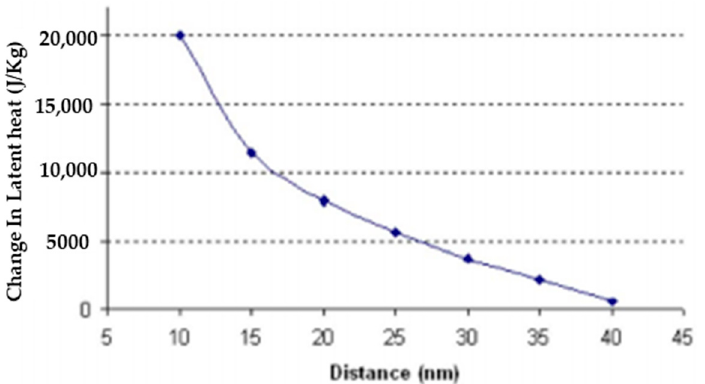
Figure 19. Relationship between latent heat transfer of shell wax/CNT NEPCM with distance between the CNT nanoparticles and PCM molecules. (Reprinted with Permission from ref. [33]. Copyright 2008 Journal of Applied Physics)